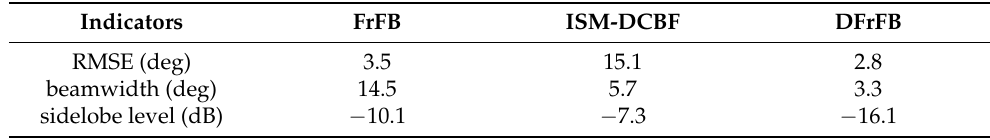
Figure 8. The estimated DOAs of nine frames of LFM signals received in the experiment. Table 3. The performance of the experiment.